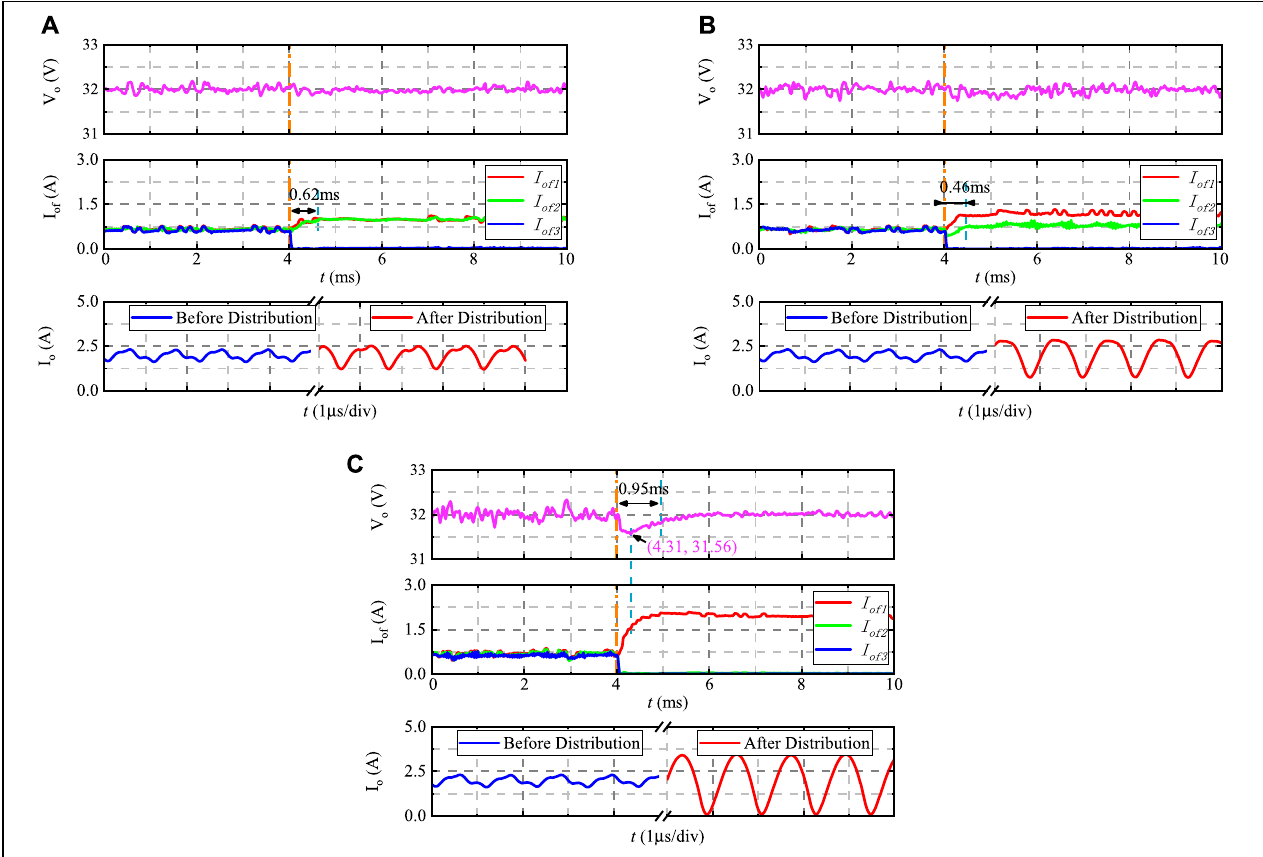
FIGURE 13 | Experimental waveforms of the load distribution scheme switching at 70-W: (A) each of the two phases outputing 50% of the power, (B) one phase outputing 60% of the power, and the other phase outputing 40%, and (C) one phase outputing 100% of the power.